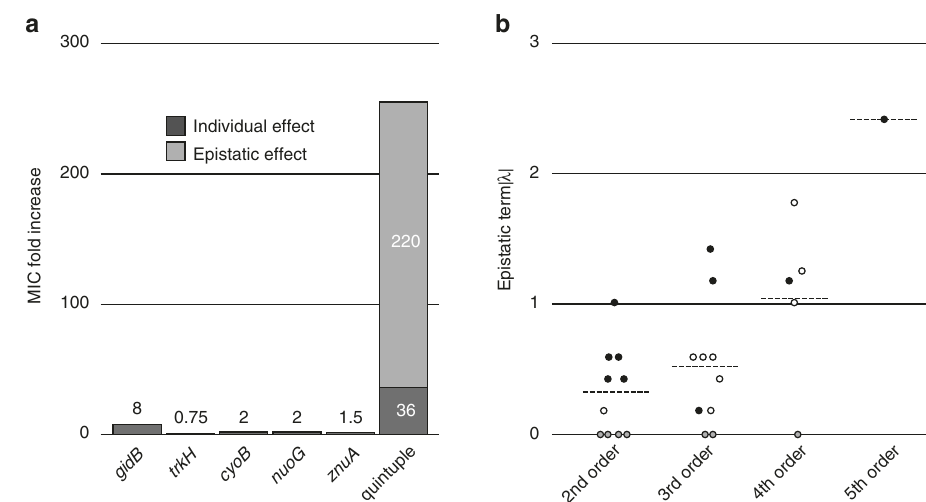
Fig. 2 Epistatic interactions. a Five mutations generate higher resistance than expected from their individual effects. The MIC increase based on individual additive effects is indicated in dark gray, while fold increase based on epistatic interactions is indicated in light gray. b The epistatic interactions increase with higher orders. Positive epistasis ( fi lled circles) predominates at the 2nd and 5th order, while negative epistasis (empty circles) predominates at 3rd and 4th order. The strongest epistasis is observed in the quintuple mutant. Gray circles represent no epistatic interactions. The full dataset of epistatic interactions can be found in Supplementary Table